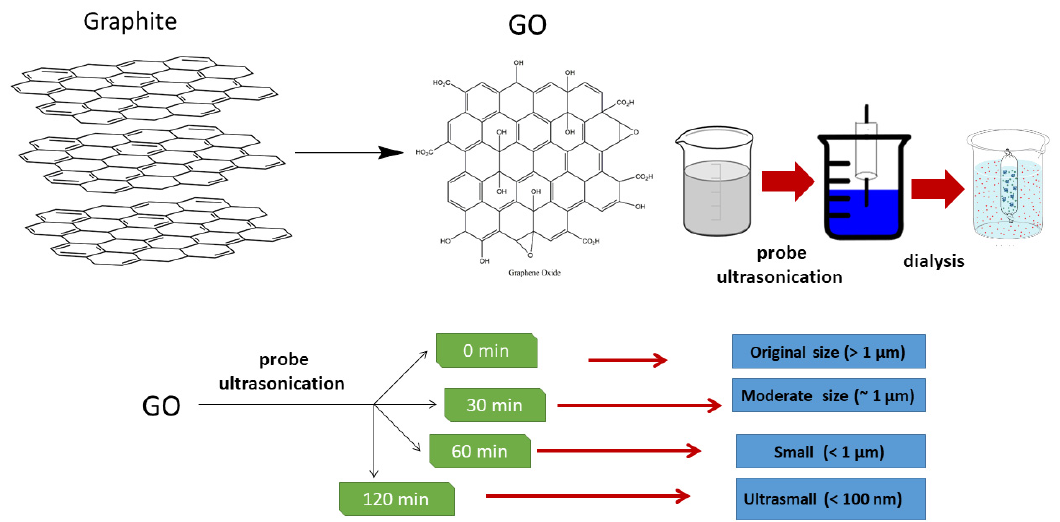
Table 1. Nanomaterial size and ζ -potential of graphene oxide (GO) with different sizes in aqueous solution (transmission electron microscopy (TEM) images were calculated for 50 pieces of GO sheets for each batch).